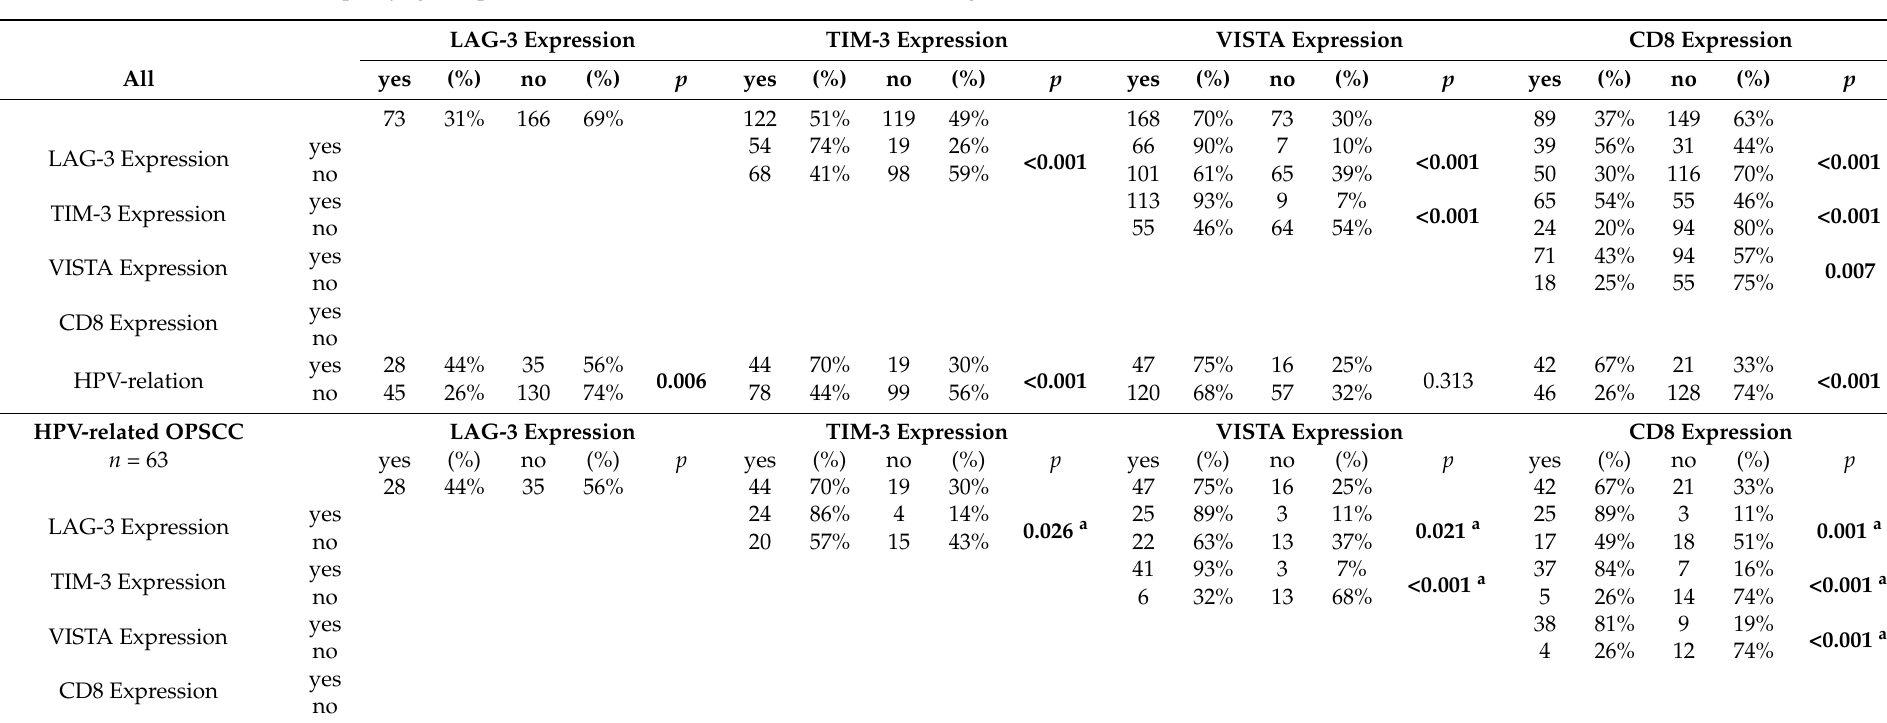
Table 2. Relation of LAG-3, TIM-3 and VISTA expression in association with CD8-positive TILs according to each other in the whole cohort ( n = 241) and according to human papillomavirus (HPV)-status (HPV-related oropharyngeal squamous cell carcinoma (OPSCC), n = 63, HPV-negative OPSCC, n = 177). LAG-3 Expression TIM-3 Expression